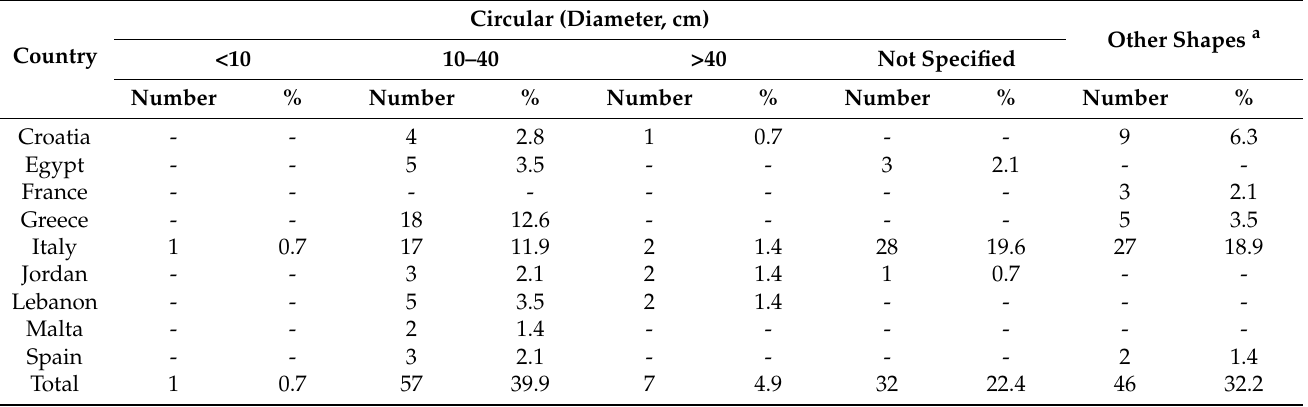
Table 8. Shape characteristics of flat breads.